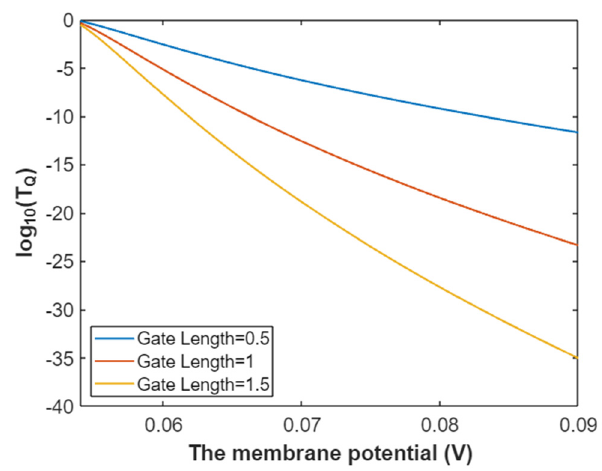
Figure 5. The relationship between the membrane potential and the common logarithm of tunneling probability of extracellular sodium ions at G = 6.33 J and over a membrane potential range from 0.054 V to 0.09 V.